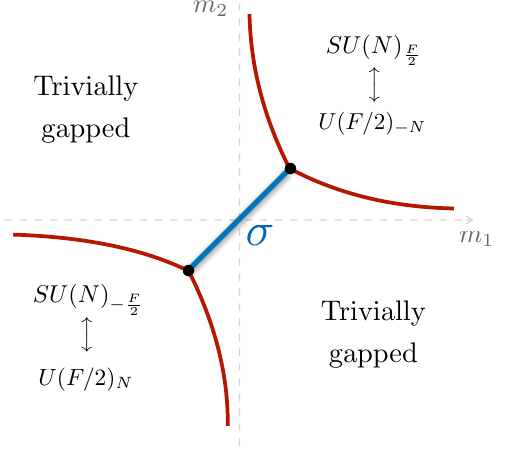
Figure 7 . Phase diagram of SU ( N ) 0 + F/ 2 ψ 1 + F/ 2 ψ 2 . In the bosonic dual picture, the red transition lines in the first and third quadrant are described by U ( F/ 2) N + F/ 2 φ , respectively. ∓ On the two black spots, where the global symmetry is enhanced, the number of scalars is F